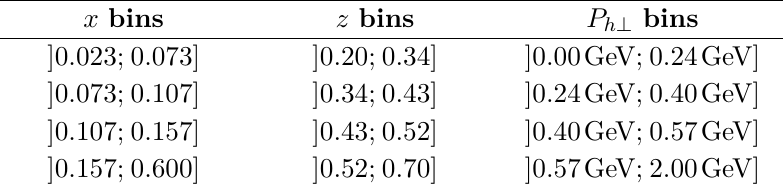
Table 6 . Definition of the three-dimensional binning for protons: the first, second, and third columns list the limits in the kinematic variables x , z , and P h ⊥ ,